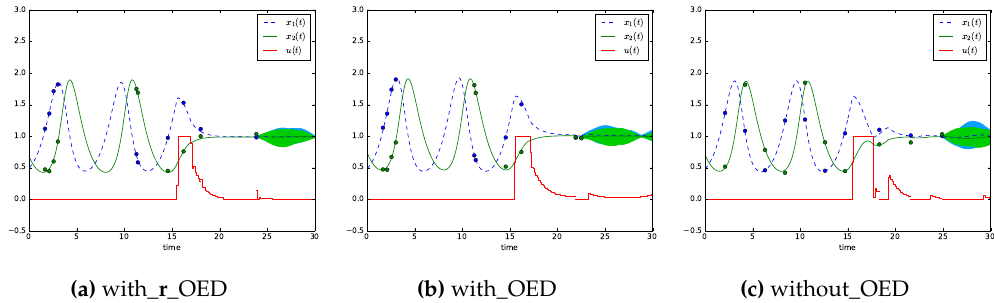
Figure 2. Visualization of three versions ( with_ r _OED , with_OED and without_OED ) of the feedback optimal control Algorithm 2 applied to the Lotka-Volterra fishing example. The algorithm is performed on the time interval [15,30]. On the time interval [0,15] seven measurements are taken for a state and parameter estimation. The estimated parameters with the corresponding uncertainties and initial states serve as input for the algorithm. In Figure 2a the robust version and in Figure 2b the non-robust version of Algorithm 2 is used with measurement time points from optimal experimental designs. Figure 2c presents the solution of algorithm 2 with measurements taken on an equidistant time grid. After the last measurement time point uncertainty tubes are computed by 100 simulations with parameter values sampled from a normal distribution with the estimated parameters as mean ˆ p = [ 0.982,0.990,1.015,1.023 ] and variance Σ ˆ p = diag ( 0.000214,0.000321,0.000347,0.000351 ) in Figure 2a, ˆ p = [ 1.014,0.998,0.981,0.977 ] and variance Σ ˆ p = diag ( 0.000231,0.000325,0.000319,0.000334 ) in Figure 2b and ˆ p = [ 1.031,1.047,0.977,0.978 ] and Σ ˆ p = diag ( 0.000413,0.000470,0.000463,0.000636 )